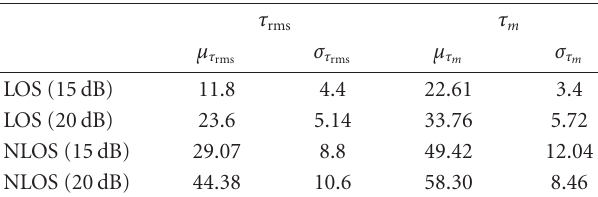
cases. Table 1: Average values of τ rms and τ m (in